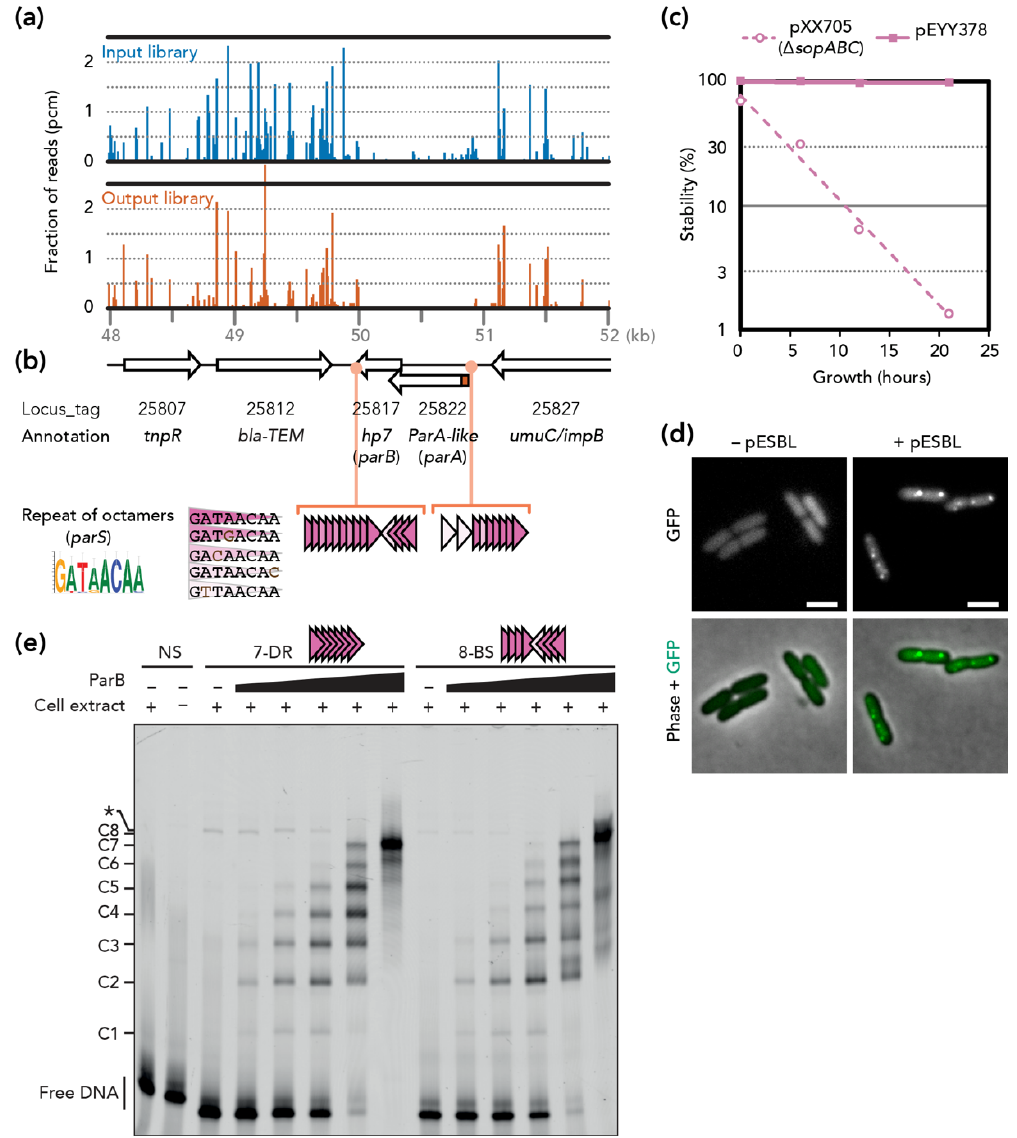
Figure 1. pESBL partitioning locus. ( a ) Tnseq reads mapped on the partitioning locus and its flanking region. Fraction of reads corresponds to the number of reads obtained for each TA dinucleotide divided by the total number of reads mapped to pESBL. ( b ) Schematic map of the region. N ‐ terminal extension of pESBL ParA (see text) is shown in red. Consensus sequence for the octamer nucleotide is shown in the sequence logo format [28]. Triangles indicate octamer repeat with or without a mismatch to the consensus sequence. ( c ) Stability of mini ‐ F plasmids. ( d ) Representative microscopy images of GFP ‐ Hp7 (ParB) in MC1061 with (+) or without (–) pESBL. Bars = 2 μ m. ( e ) EMSA. dsDNA probes were incubated (+) or not (–) with cell extract containing increasing amounts of ParB (black triangle with a range of 1, 3, 10, 30, 100). The positions of various protein–DNA complexes (C1 ‐ C8) and free DNA fragments are indicated on the left. A non ‐ specific complex, indicated by an asterisk (*), is observed in ParB ‐ free extract with probes 7 ‐ DR and 8 ‐ BS but not with non ‐ specific DNA (NS) (Figure S1b).